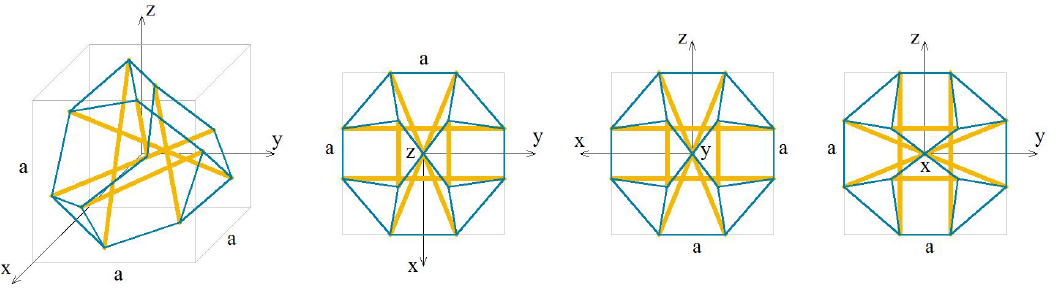
Figure 13. Geometry of the truncated tetrahedron module.